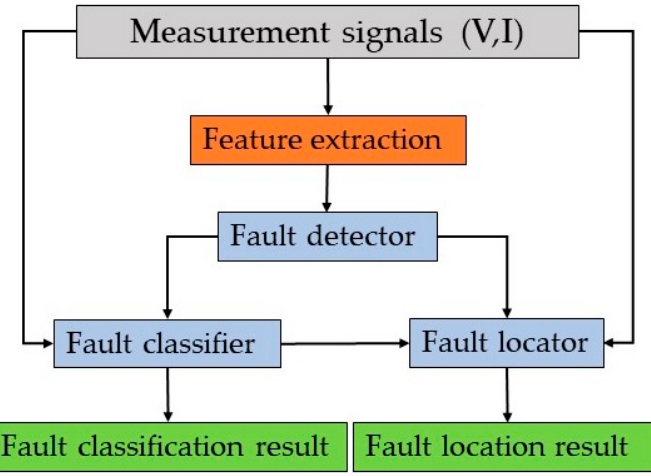
Figure 7. Fault location, classification, detection framework [73].